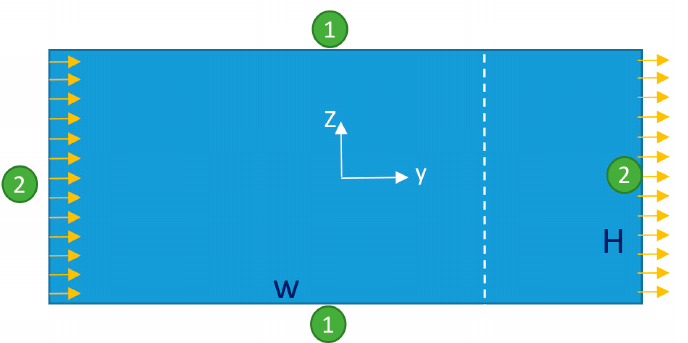
Figure 3. The geometry of the model simulated in [43], regenerated here for the sake of validation. The orange arrows represent the actuated velocity. The number adjacent to each boundary specifies its boundary condition which is described in Equation (24) with the same boundary numbers. The line graphs of Figure 4 are plotted on the white dashed line shown in this figure.